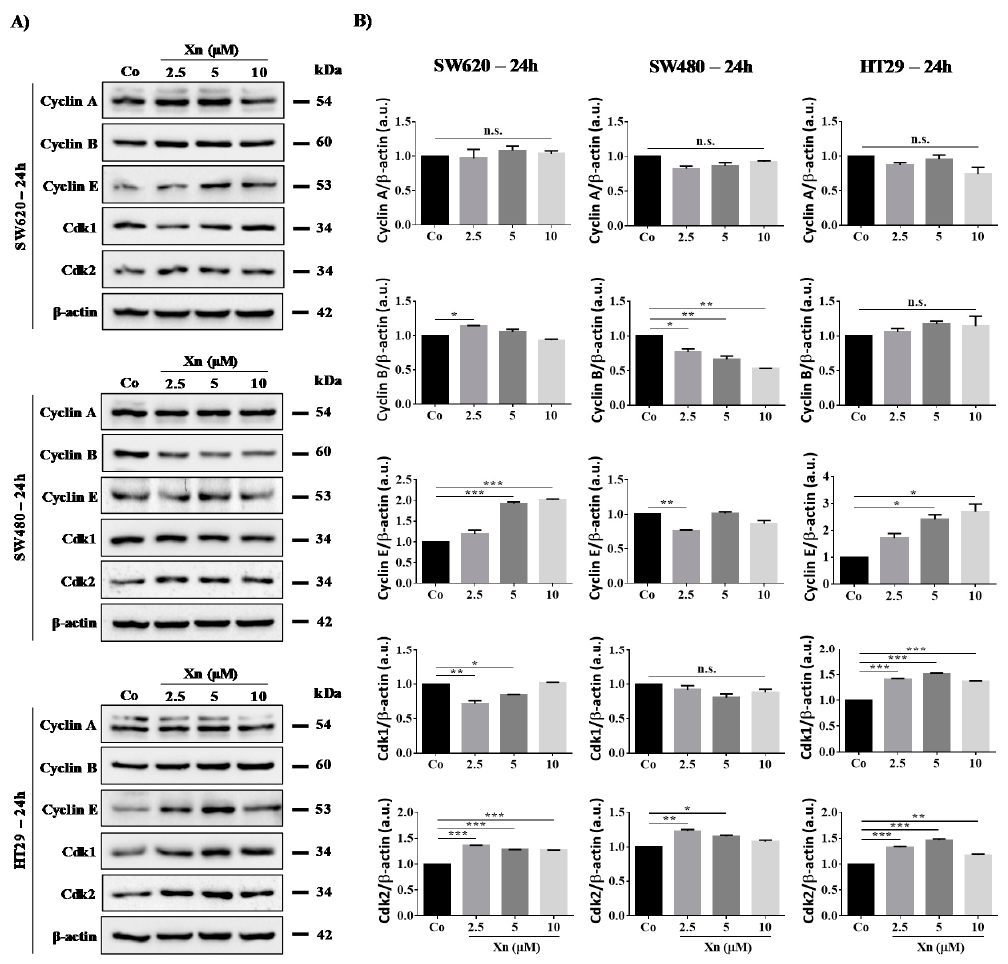
Figure 3. Modulation of key cell cycle regulators after 24 h of treatment with xanthohumol (Xn) in colon cancer cell lines. ( A ) Immunoblot analysis of Cyclin A, B, E, Cdk1, and Cdk2 in Xn (2.5, 5, and 10 µM)-treated SW620, SW480, and HT29 cells for 24 h. β -actin: loading control. ( B ) Densitometry